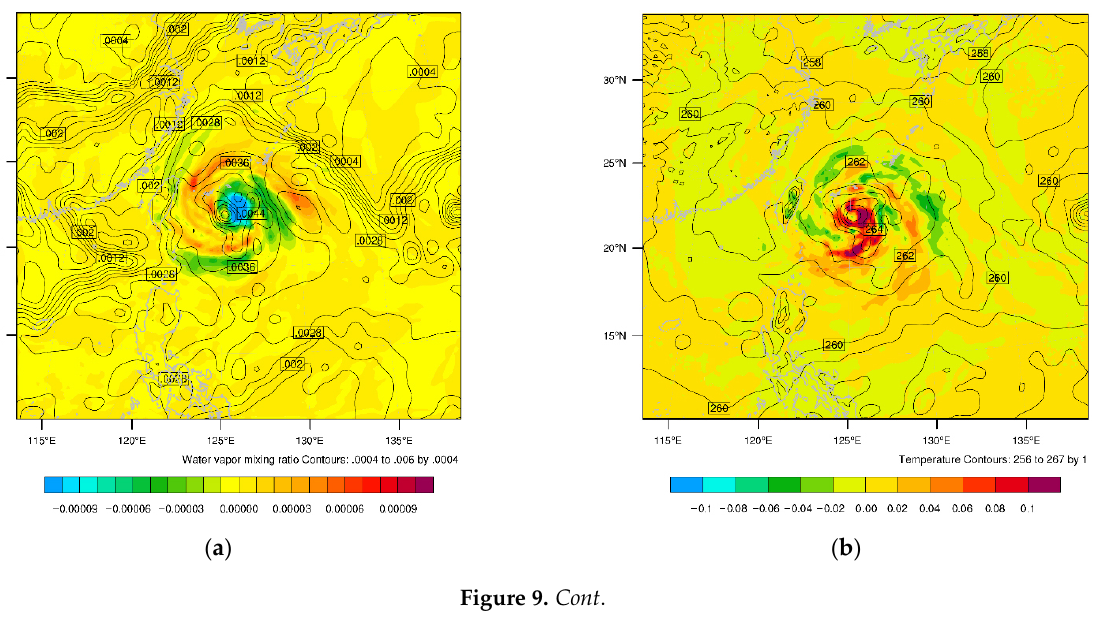
( c ) Figure 9. Analysis increments at 500 hPa of ( a ) water vapor mixing ration (shaded; kg/kg), ( b ) temperature (shaded; K), and ( c ) x-component of wind (shaded; m/s) of the single GEOMS radiance observation test. The black solid lines represent the corresponding background variables, respectively, at analysis time 0600 UTC 8 August. 5.2. RMSE Verification Against ERA-5 Figure 10a displays the average 24 h forecasting RMSE vertical profiles of water va- por mixing ratio, temperature, and zonal wind, respectively, which uses the ERA-5 data as truth. For humidity, the NDA experiment generated the worst result, while CDA-3 yielded the lowest RMSEs and was slightly better than CDA-2. The SDA is only better than the NDA, while the performance of CDA-1 lies between CDA-2 and SDA. The five experiments obtained similar results at above 400 hPa but show the advantages of assim- ilating GEOMS radiances in the middle and lower levels, indicating that valuable tropo- spheric humidity information from a low-level atmosphere can be extracted from GEOMS humidity sounder radiances. For temperature, differences between experiments become clear at below 150 hPa. SDA showed little impact on the temperature fields compared to NDA because of the lack of enough rapidly updated information from GEOMS radiances.